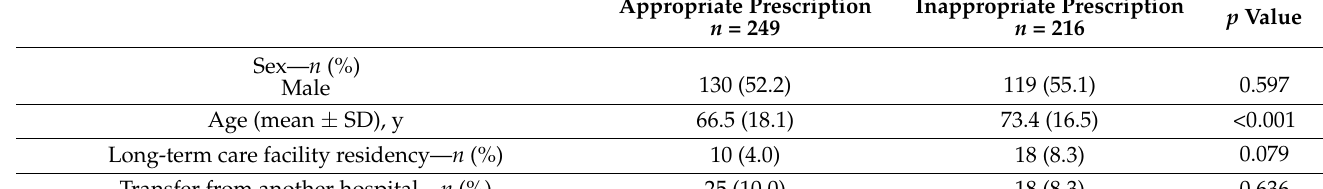
Table 2. Characteristics of empirical ceftriaxone prescriptions, according to appropriateness.